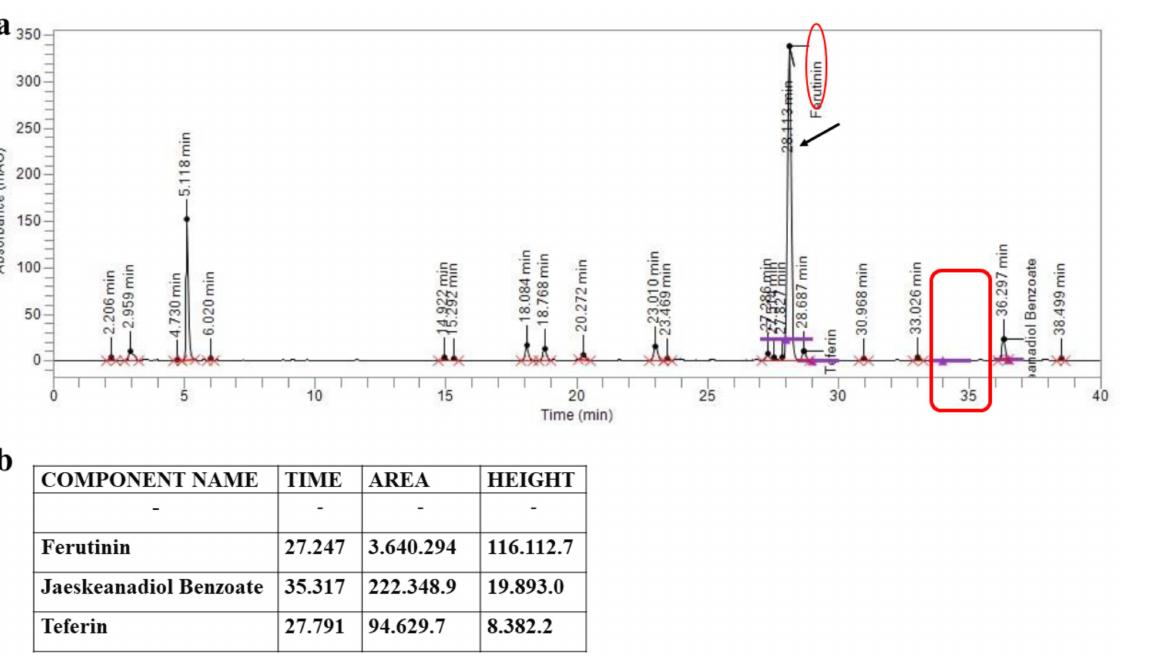
Figure 2. HPLC spectrum of FER-E in which ferulenol is absent. In panel ( a ) the HPLC spectrum of FER-E is shown. In panel ( b ), HPLC analysis values are